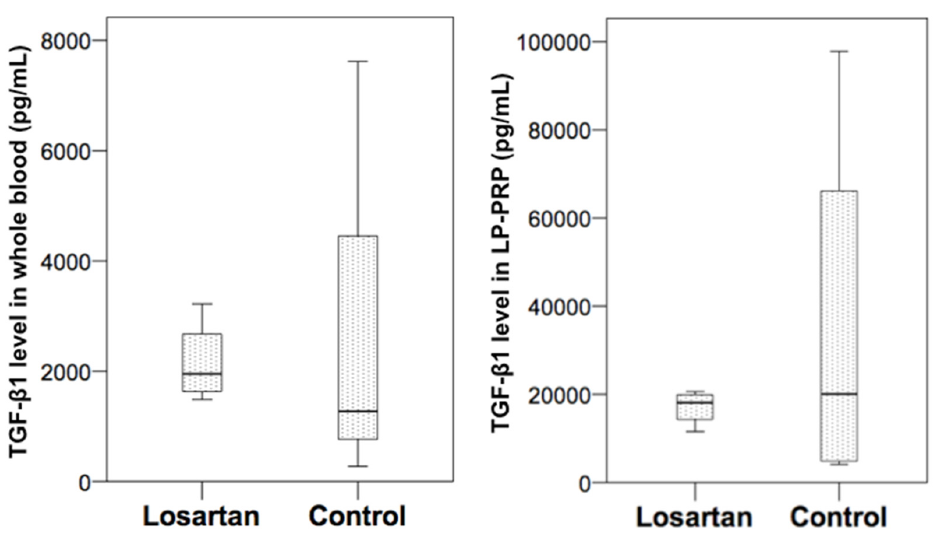
Figure 1. Losartan and control group comparison of transforming growth factor-beta 1 (TGF- β 1) levels in whole blood (WB) and leukocyte-poor platelet-rich plasma